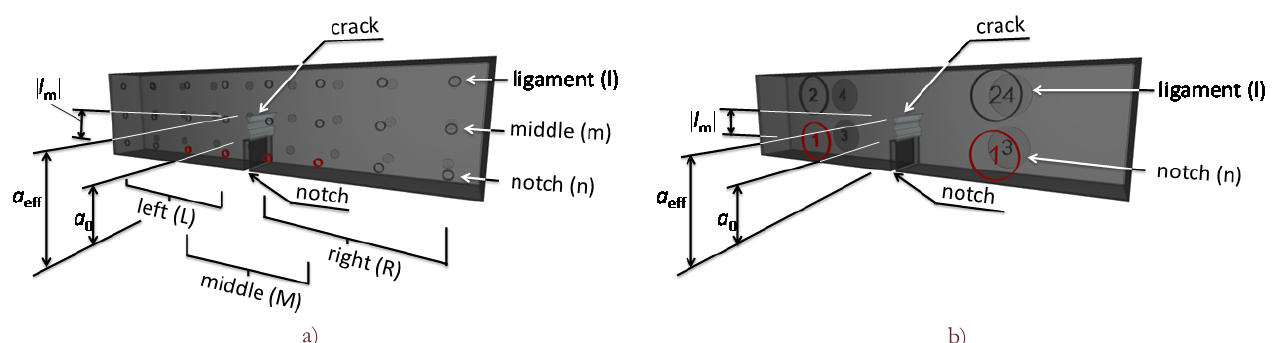
Figure 3: Illustration of positioning of probes of the measuring devices on the test specimen in the case of electrical resistivity measurements (a) and the ultrasonic measurements